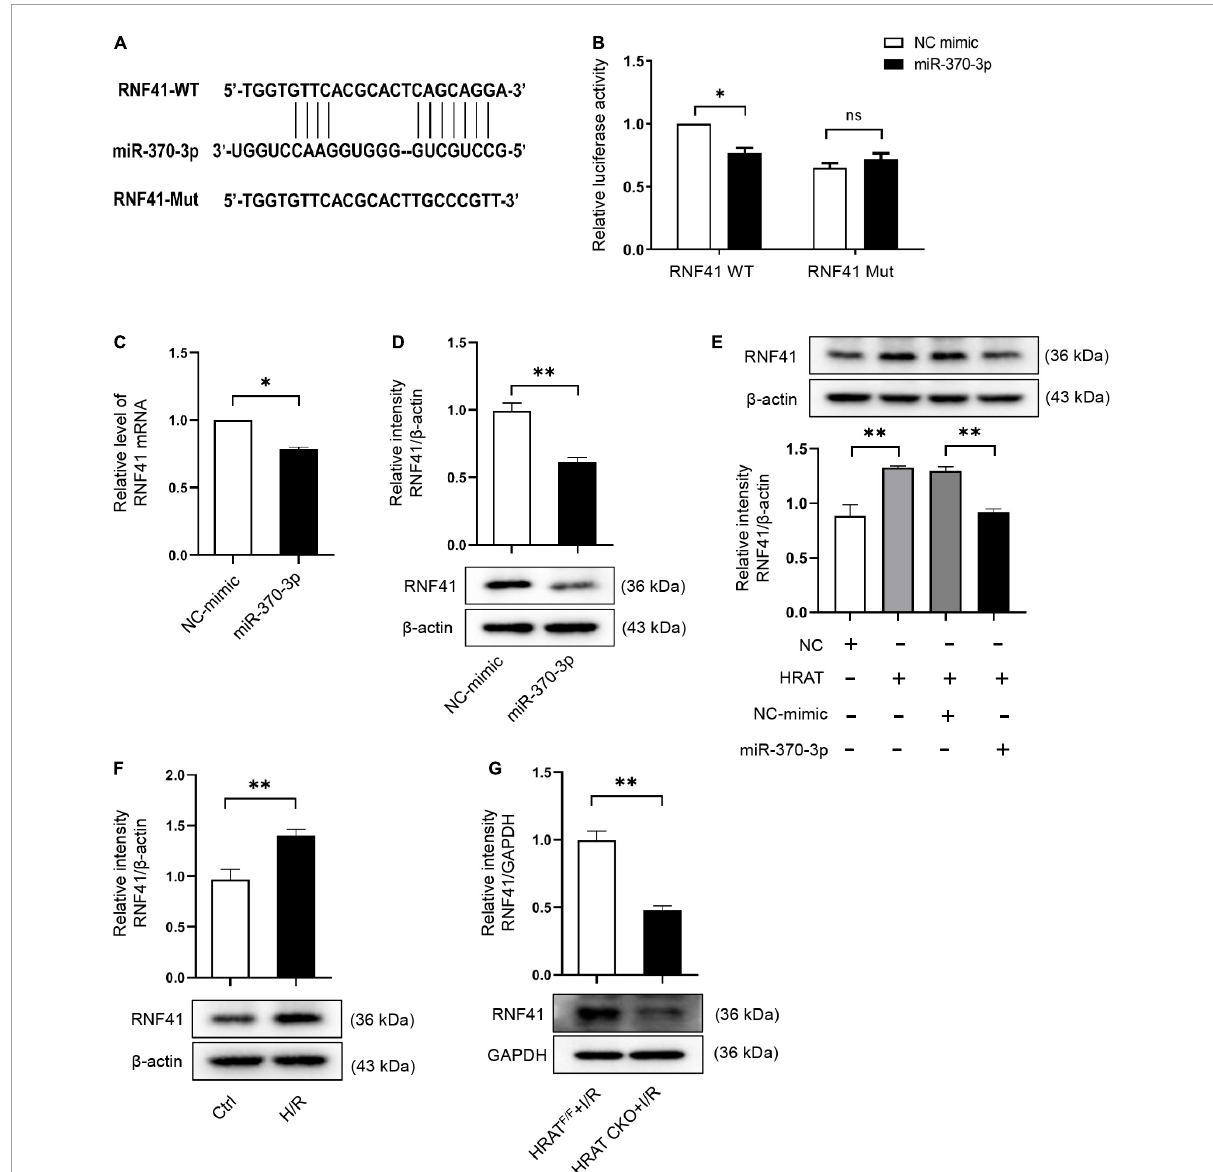
FIGURE7 RNF41 is a downstream target of miR-370-3p. (A) Predicted binding site between RNF41 and miR-370-3p. (B) The relative luciferase activity of the RNF41 wild-type/mutant reporter in HEK-293T cells with or without miR-370-3p mimics was analyzed by dual luciferase reporter assay ( n = 3). MRNA (C) and Protein (D) levels of RNF41 in H9c2 cells with or without miR-370-3p mimics ( n = 3). (E) Protein levels of RNF41 in different groups of cells were tested via Western blot ( n = 3). (F) Protein levels of RNF41 in Ctrl and H/R cells were examined by Western blot ( n = 3). (G) Protein levels of RNF41 in the hearts from HRAT F / F and HRAT CKO mice subjected to I/R (45’/3 hr) was detected by Western blot ( n = 5). All the data are described as the mean ± SD. * P < 0.05, ** P < 0.01, ns = not